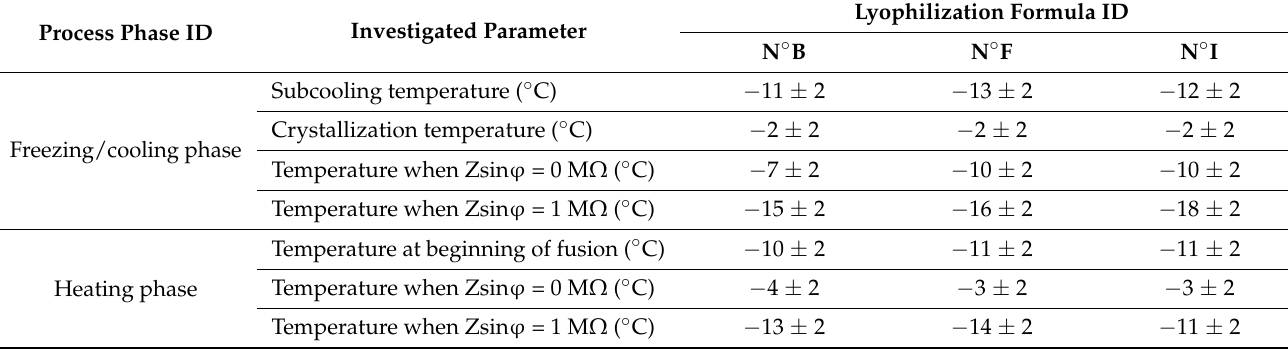
Table A2. Experimental results of thermal and electrical property determination of selected cryo- and lyo-protectant formulas used to lyophilize dermal FPCs. Presented data were experimentally gathered during freezing/cooling and heating phases of placebo formulations using formulas B, F, and I. FPC, fibroblast progenitor cells; Zsin ϕ , impedance analysis parameter.